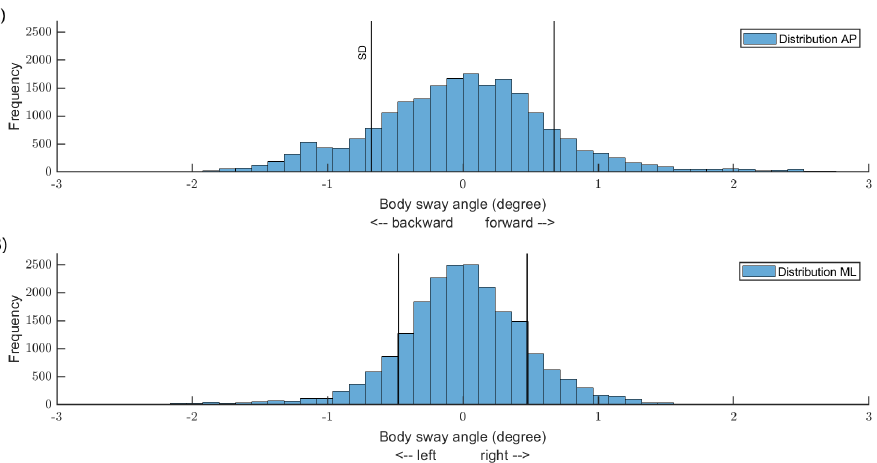
Figure 2. Distribution of the body sway angle of a representative participant standing on the foam surface with eyes closed. Panel ( A ) body sway angle along the AP axis. Panel ( B ) body sway angle along the ML axis. On both panels, vertical black lines depict one standard deviation (SD), that is, the participant-specific threshold to provide vibrotactile feedback.